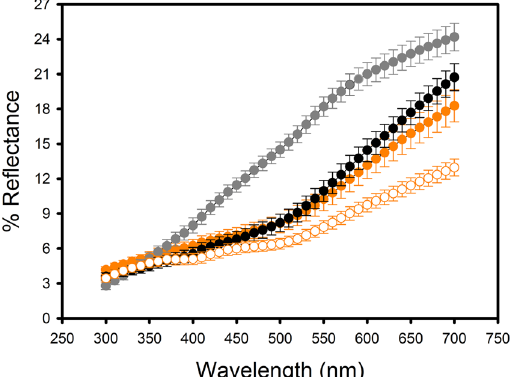
Figure 2. Mean ( ± s.e.) reflectance spectra of feathers colored by pheomelanin in the Eurasian nuthatches used in the study. Orange color: flank feathers. Grey color: breast feathers. Black color: undertail feathers. Solid symbols: adults. Open symbols: